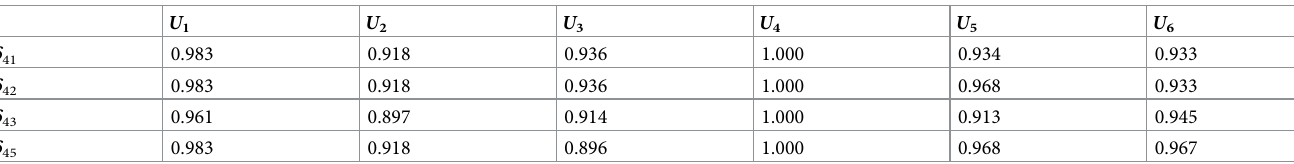
Table 17. The relative weight of O 4 to others.